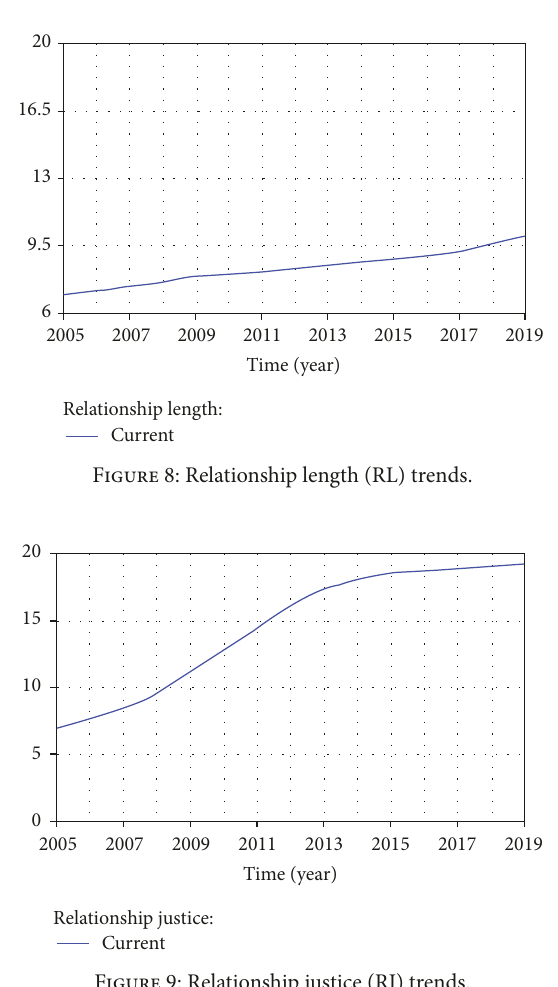
Figure 11: Trends for amount of relational psychological contract implemented